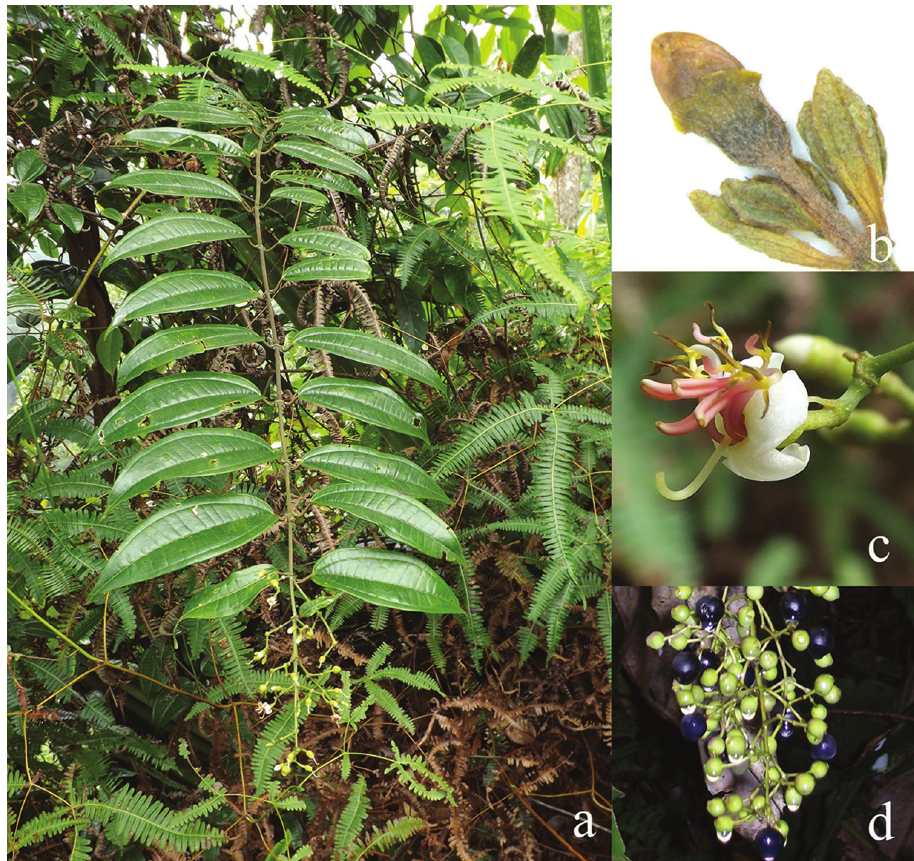
Figure 16. Dissochaeta gracilis. a habit b hypanthium c flower d fruits. Photographs by A. Kartonegoro; vouchers: Kartonegoro 1113 (BO,